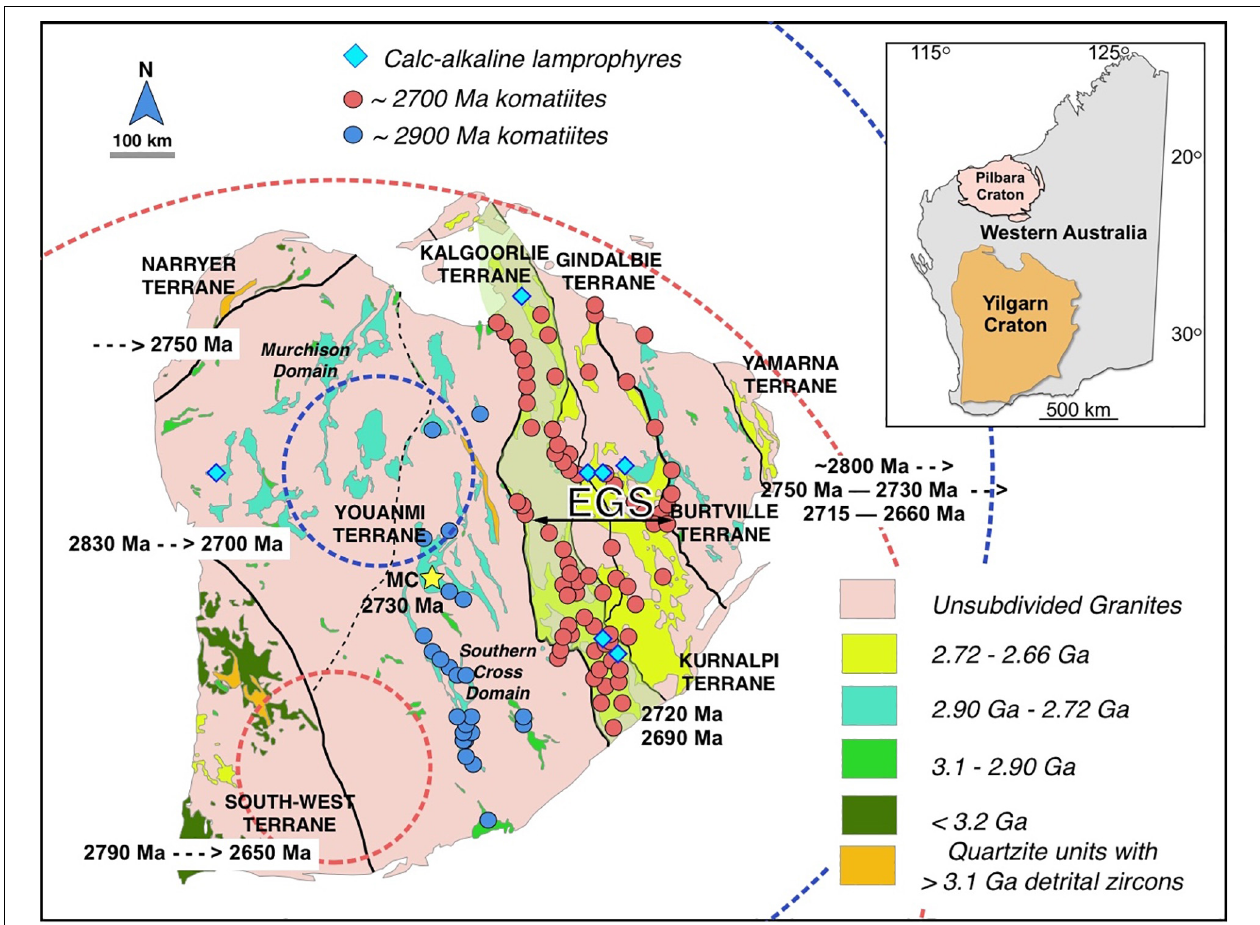
FIGURE 3 | Geological summary map of the Yilgarn Craton. Also shown: approximate plume stem and head locations for the ∼ 2900 Ma (dashed blue circles) and ∼ 2700 Ma (dashed red circles) komatiite source plumes from Mole et al. (2014). The younger komatiites in the Eastern Goldfields Superterrane (EGS) erupted between arc-type volcanism dated between 2830 and 2700 Ma to the west and > 2720–2660 Ma arc-type volcanism to the east. Similarly, 3100–2900 Ma arc-type volcanism occurred to the east and west of the 2900 Ma komatiites, although exposures of these rocks are not as voluminous. Map adapted from Martin et al. (2015) and Witt et al. (2018). Komatiite locations from Barnes et al. (2016). See also Wyman (2019) for further discussion of Yilgarn Craton volcanism. Dates from the cited literature for inward-facing subduction zones. Narryer Terrane – stitched to Yilgarn by 2750 Ma (Spaggiari et al., 2007); Murchison Domain : 2830–2700 Ma subduction-linked volcanism (Wyman, 2019; Lowrey et al., 2020); South-West Terrane : 2790–2650 Ma greenstone belts (Wilde et al., 1996); Burtville and Yamarna Terranes : ∼ 2800 Ma based on similarities with Youanmi (Wyman, 2019 and references therein; > 2750–2730 Ma based on Begg et al., 2010; Pawley et al., 2012; 2715–2660 Ma based on Kositcin et al., 2008; Czarnota et al., 2010; Pawley et al., 2012). Kalgoorlie Terrane Large Igneous Provinc e (shaded green): 2720–2690 Ma based on Hayman et al., 2015). EGS = Eastern Goldfields Superterrane . MC (yellow star) Marda Complex sanukitoids ∼ 2730 Ma (Nelson, 2001). Blue diamonds: Locations of calc-alkaline/shoshonitic ∼ 2684–2640 Ma orogenic lamprophyres from Choi et al. (2020) and Egan (2020). Note that the present post-orogenic locations of the subduction-related rocks does not correspond exactly to the locations of the associated subduction zones. Inset: Locations of the Yilgarn and Pilbara Cratons relative to Western